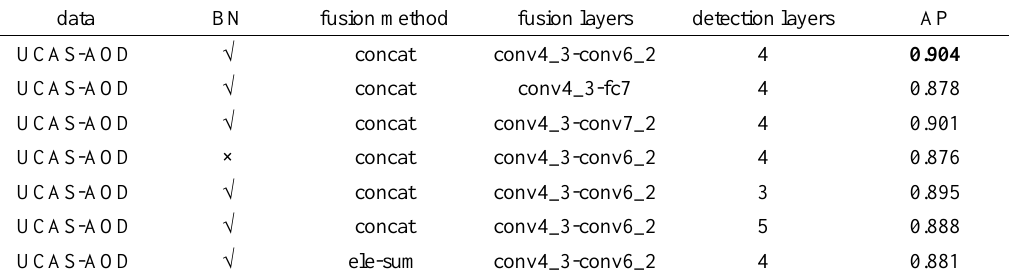
Table 1. Results of the ablation study on UCAS-ADC. BN means that batch normalization layer is added in the detection layer. The options of layers we can fuse include conv4_3, fc 7, conv6 2. The fusion layers represents the layers we choose to merge. The detection layers represents the number of detection layers. The AP is measured on UCAS-AOD test set.